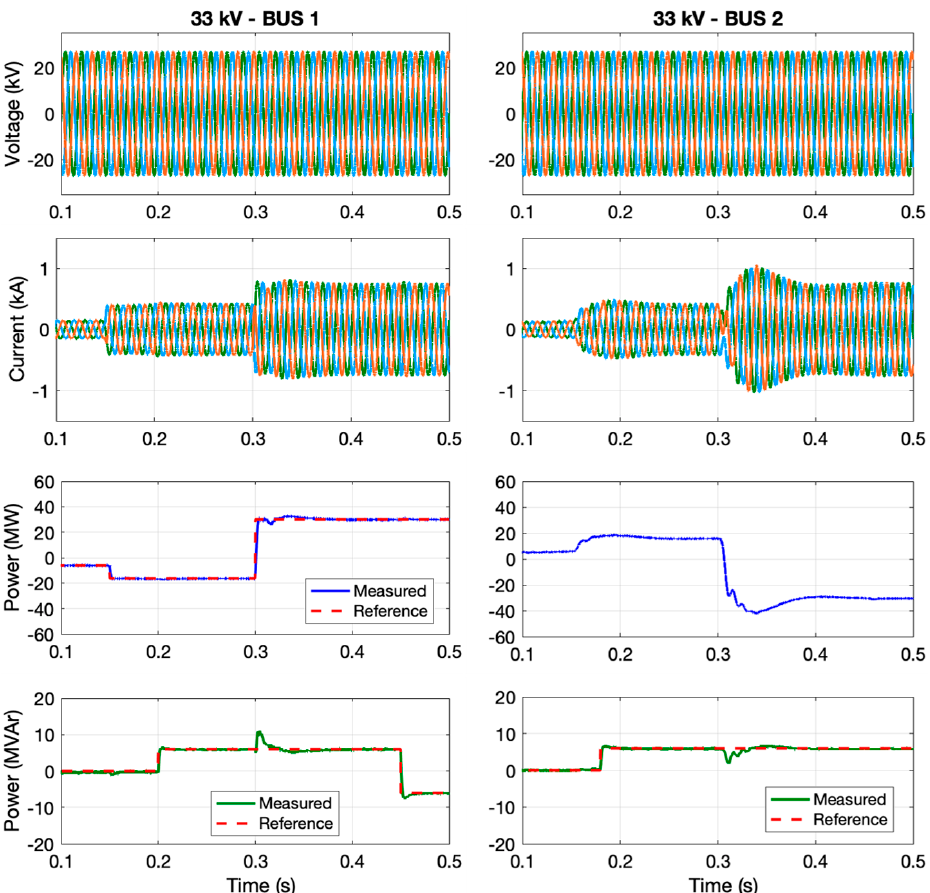
Figure 24. The power flow control response of the MVDC system subjected to step changes in active and reactive power: voltage and current traces and active and reactive power (BUS 1 on the left, BUS 2 on the right).